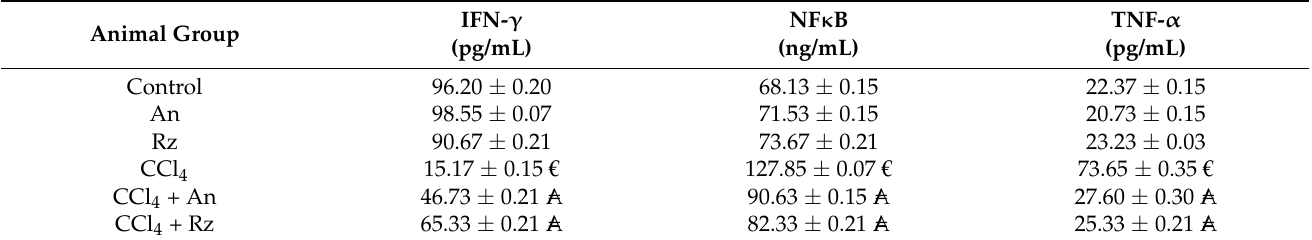
Table 8. Ameliorative effects of An or Rz administration on the serum levels of IFN- γ and NF κ B in different experimental groups following CCl 4 -induced hepatotoxicity.